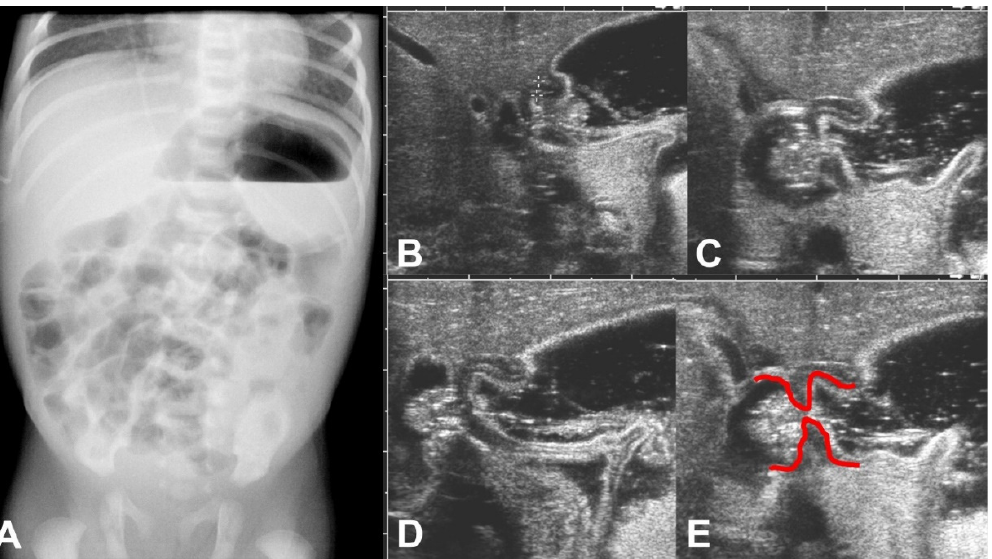
Figure 1. ( A – E ): ( A ) Erect plain abdominal X-ray on day 5 of life showed an enlarged stomach with an air-fluid level but was otherwise unsuspicious. ( B – E ) Sonographic examination on the same day showed a failure to pass gastric content, illustrated here in a sequence of ultrasound images during the gastric peristaltic wave. Furthermore, shouldering of the pylorus can be seen pointed out by red markings in ( E ).